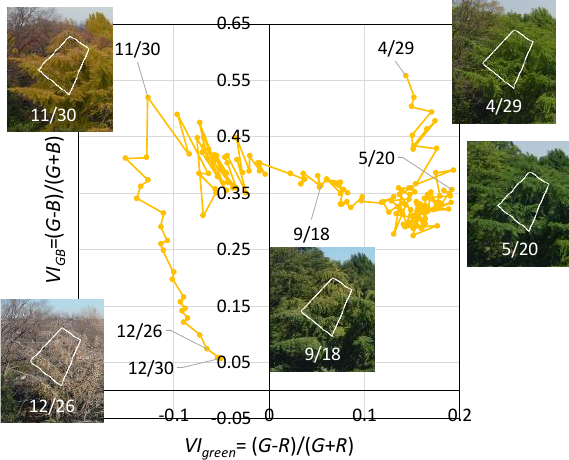
Figure 7. Time series changing of G. biloba on coordinate in feature space of VI green and VI